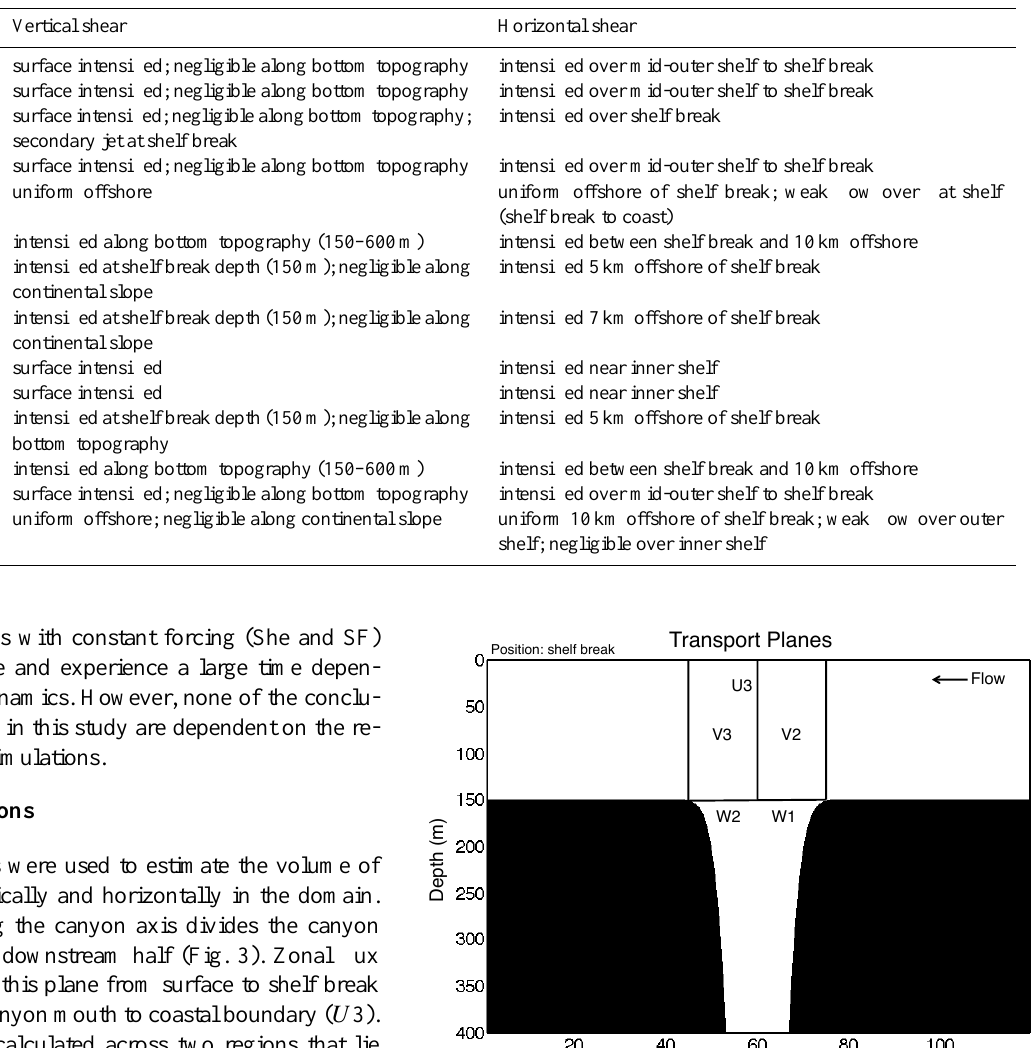
Table 4. Forcing flow for all model simulations.